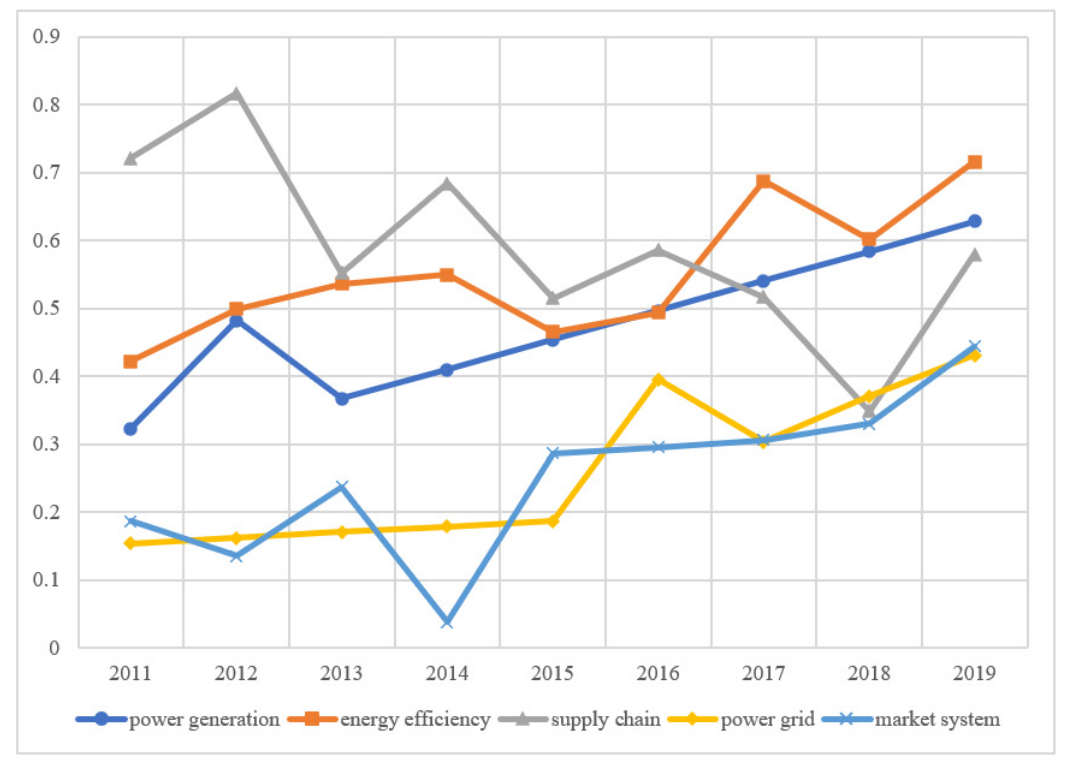
Figure 3. Evaluation score of low-carbon development in eastern China.